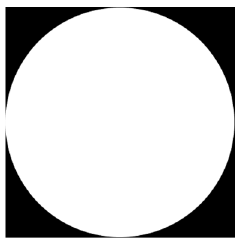
Figure 4. Example of image generation for circle PSA.